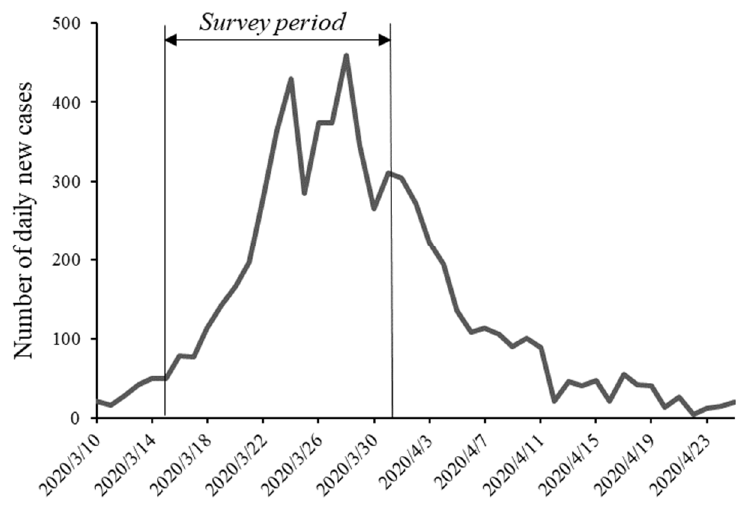
Figure 2. Number of daily new confirmed coronavirus cases in Australia. Data source: https://www.health.gov.au/news/health-alerts/novel-coronavirus-2019-ncov-health-alert/corona- virus-covid-19-current-situation-and-case-numbers (accessed on 1 August 2020)